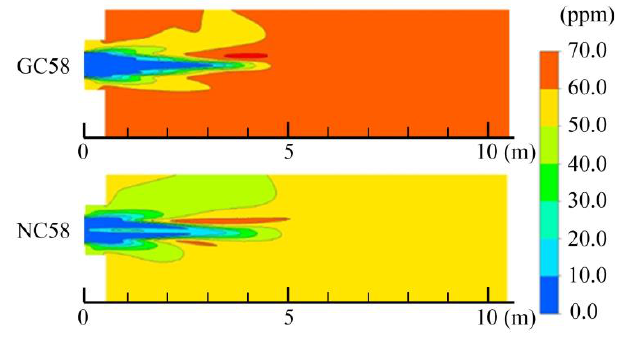
Figure 15. The distribution of NO for GC58 and NC58.